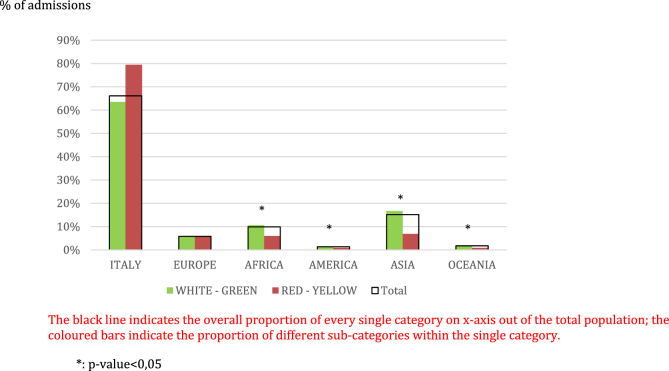
Admission codes clustered by origin.